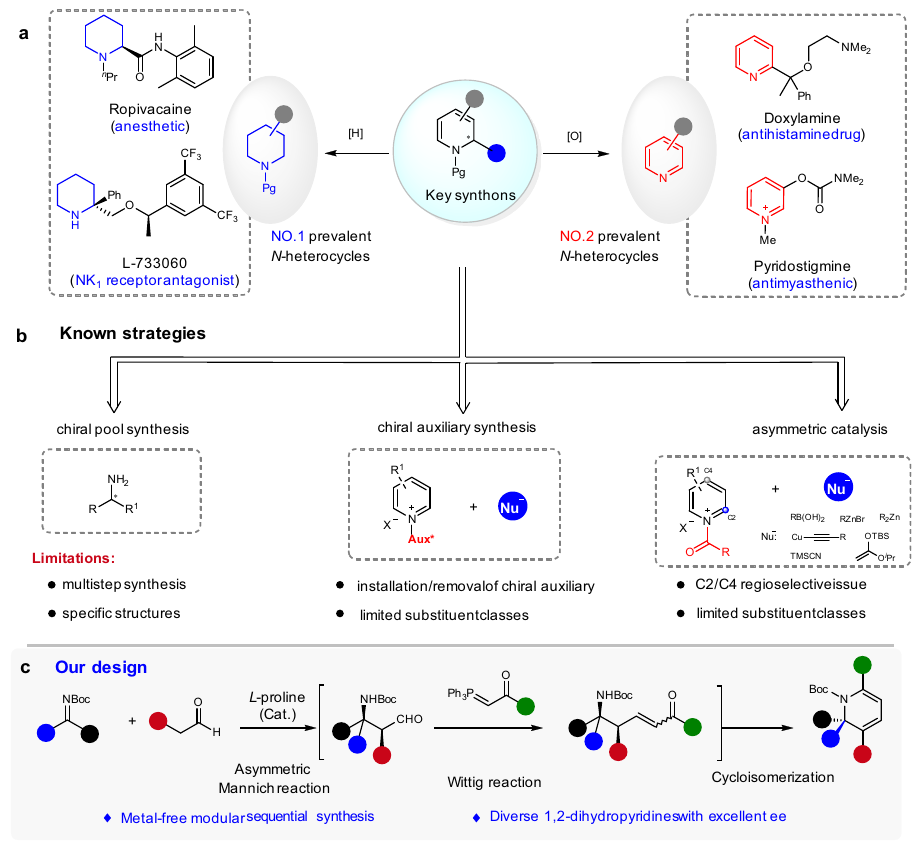
Fig. 1 Reaction development. a Selected drugs featuring a piperidine or pyridine core. b Known strategies to chiral 1,2-dihydropyridines. c Organocatalytic Mannich/Wittig/cycloisomerization sequence to chiral